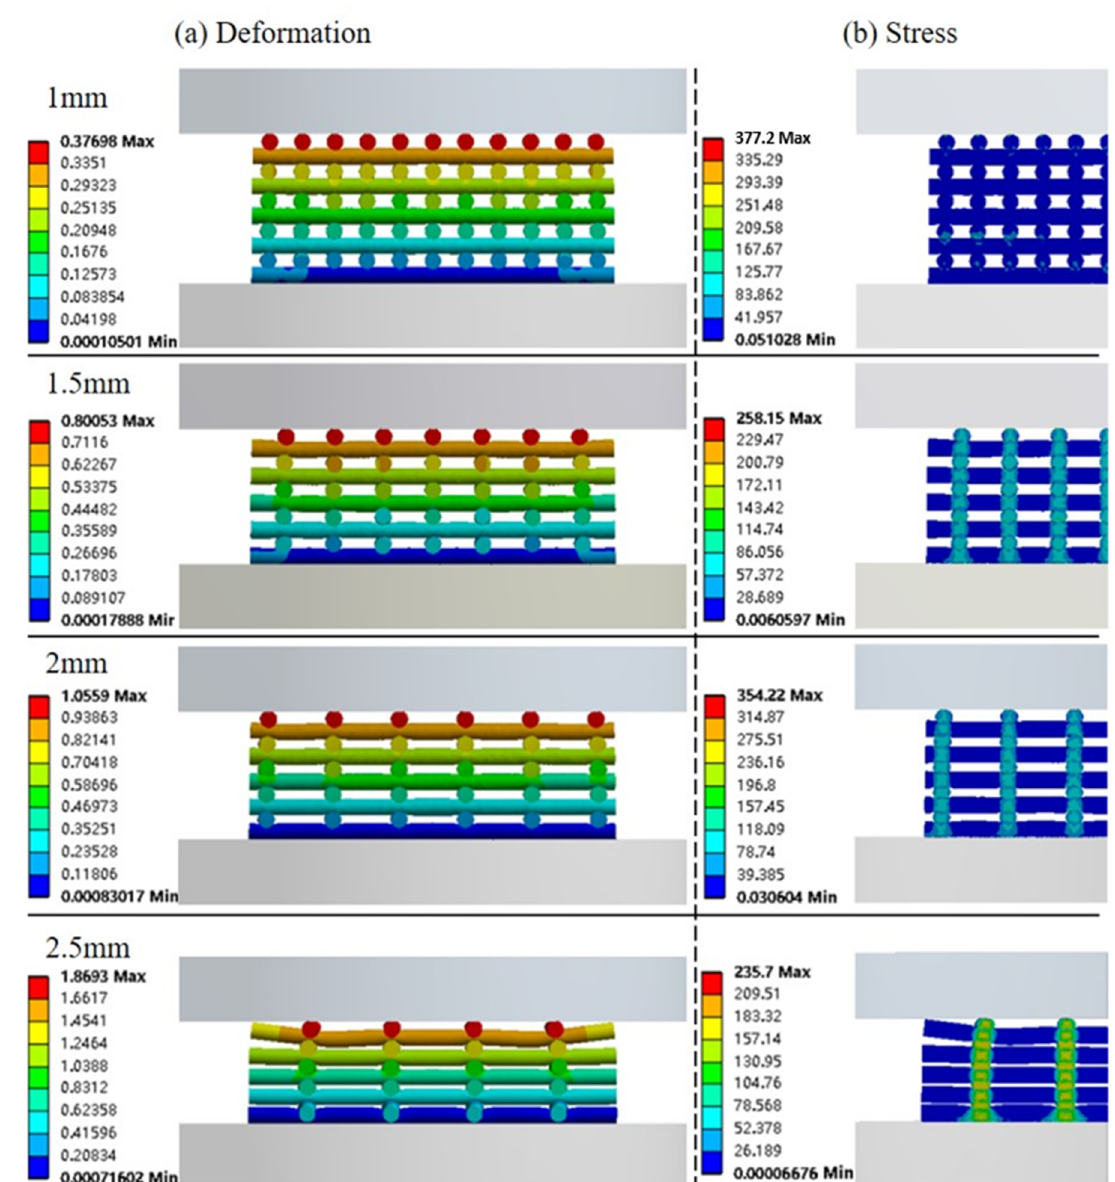
Figure 9. Numerical results showing the ( a ) deformation of the scaffold and ( b ) the stress contours plot for half of the scaffold under a compressive load of 400